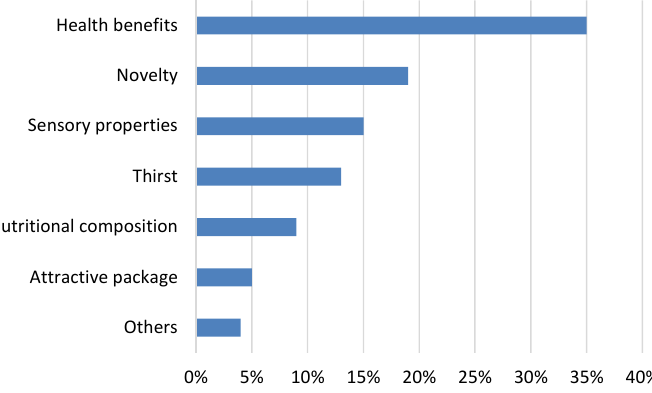
Figure 2. Reasons for consumption of Bissap beverage by Portuguese consumers.